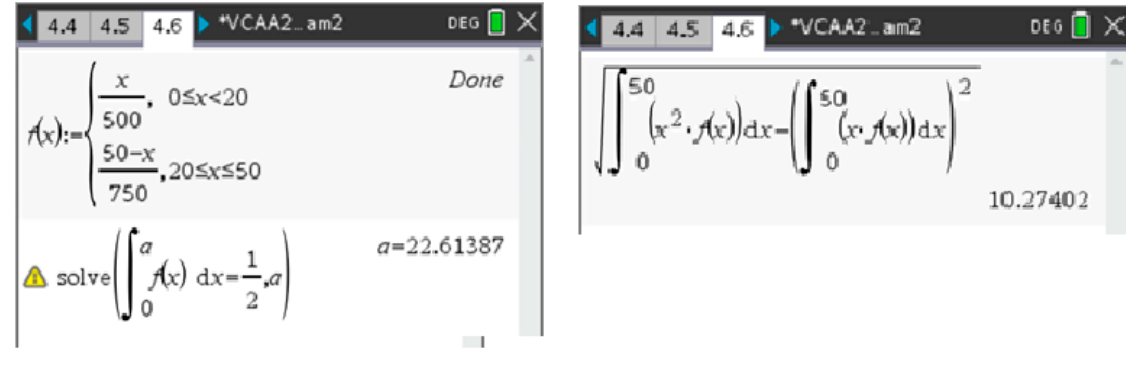
Figure 5. The 2021 Mathematical Methods Examination 2, screen shots solving Question 4.